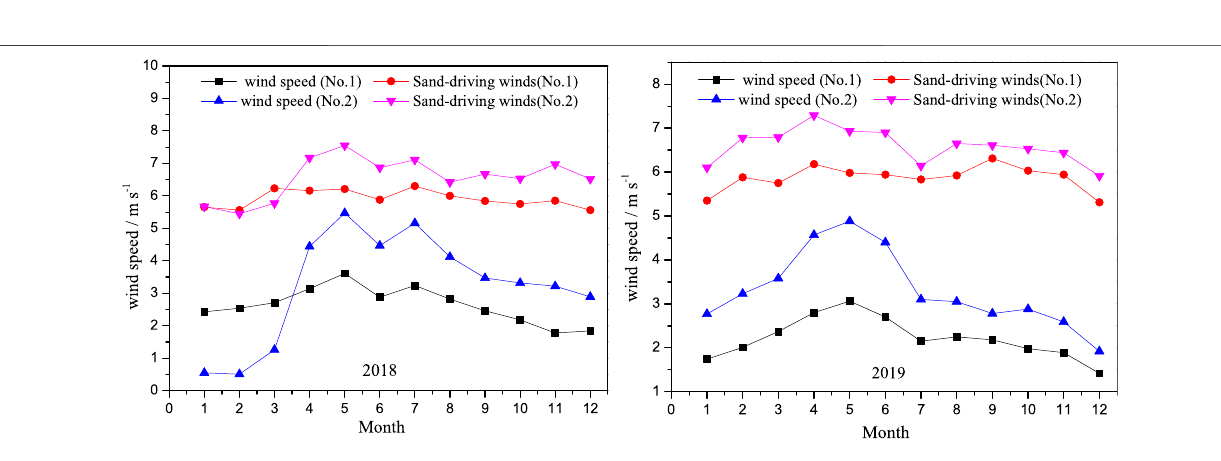
FIGURE 7 | Particle size of sandy materials at different depths in the experimental observation fi